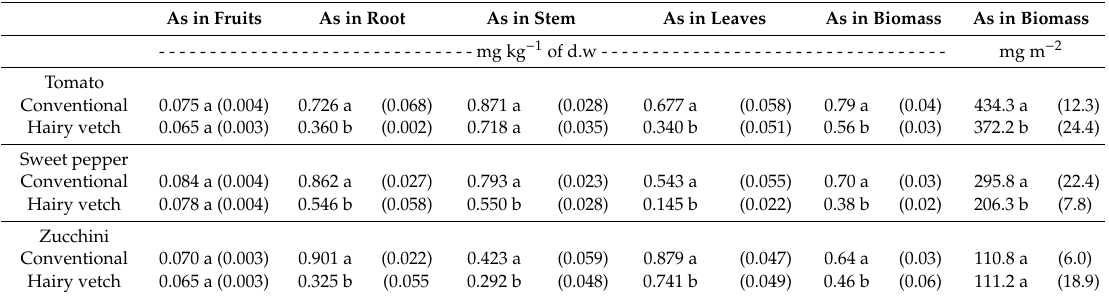
Table 4. E ff ect of the hairy vetch mulching on the As uptake in fruit, root, stem, leaves and total biomass. As in Fruits As in Root As in Stem As in Leaves As in Biomass Tomato